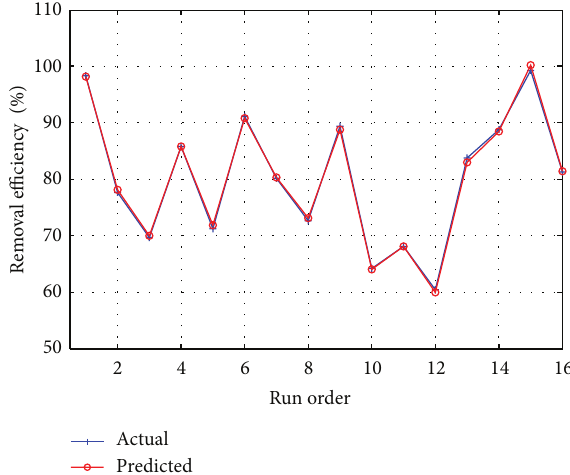
Figure 6: Gaussian probability density function of the residuals. Figure 7: Actual and predicted Cu(II) removal